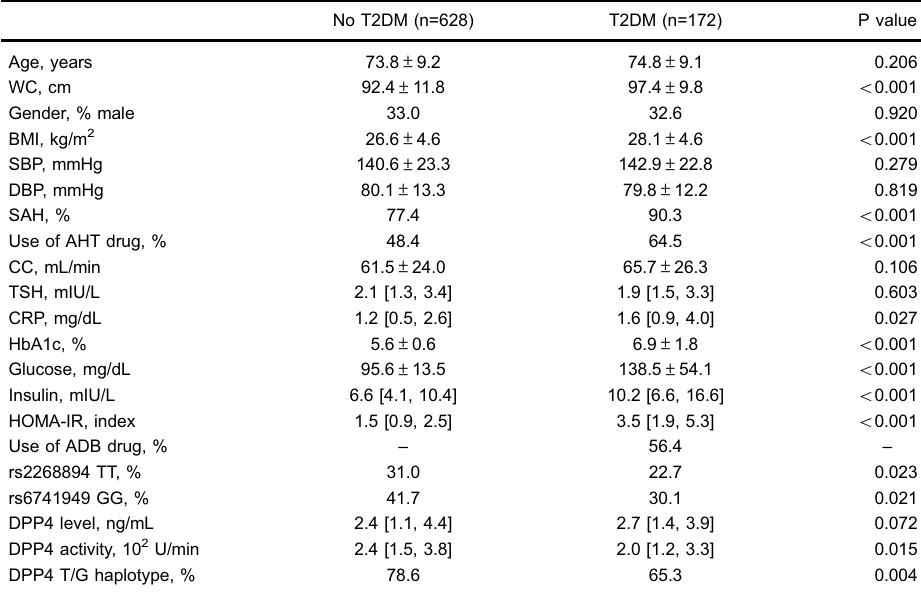
Table 1. Comparison of clinical traits, fasting biochemistry, and haplotypic frequencies across non-diabetic and diabetic subjects. No T2DM